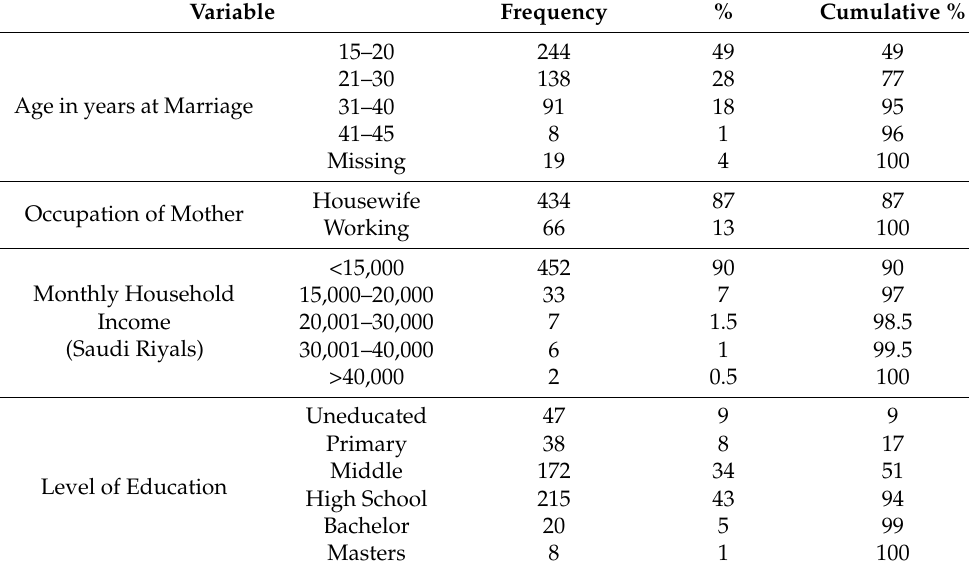
Table 1. Demographic Profile of Mothers ( n =